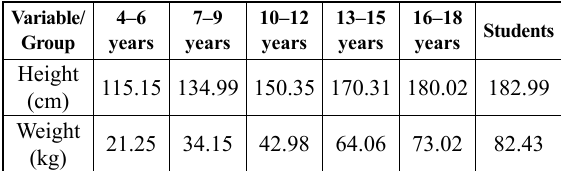
Table 1. Participants included in this study